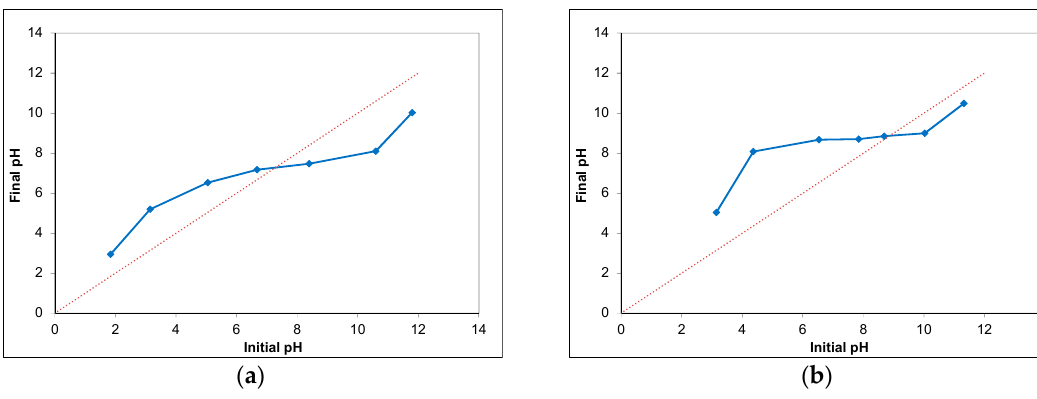
Figure 10. Determination of the pH PZC of ZnO films: ( a ) nanowires; and ( b ) nanoparticles.